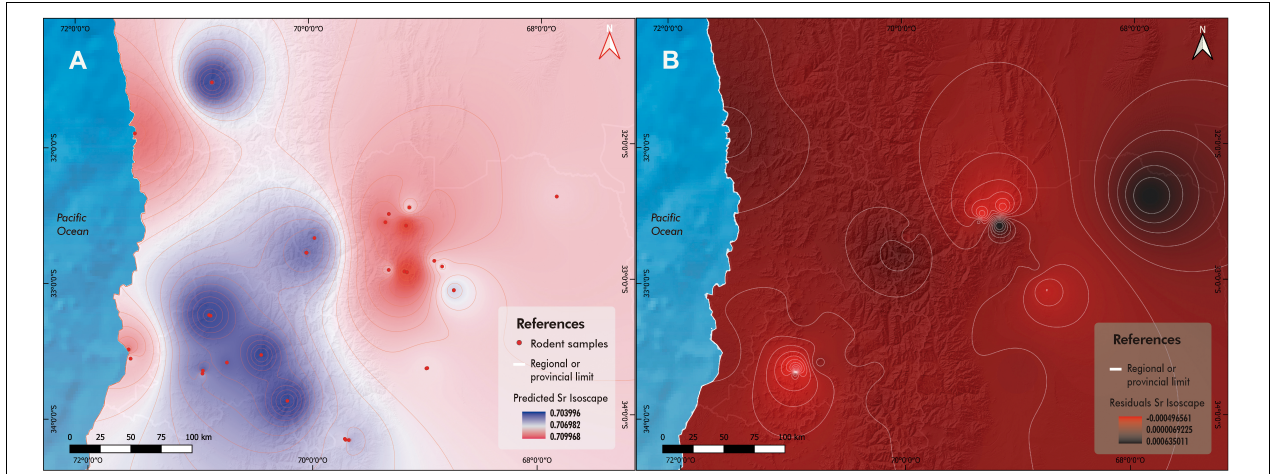
FIGURE 8 | “Rodents” model: (A) Random Forest bioavailable strontium isoscape. (B) Associated uncertainty.